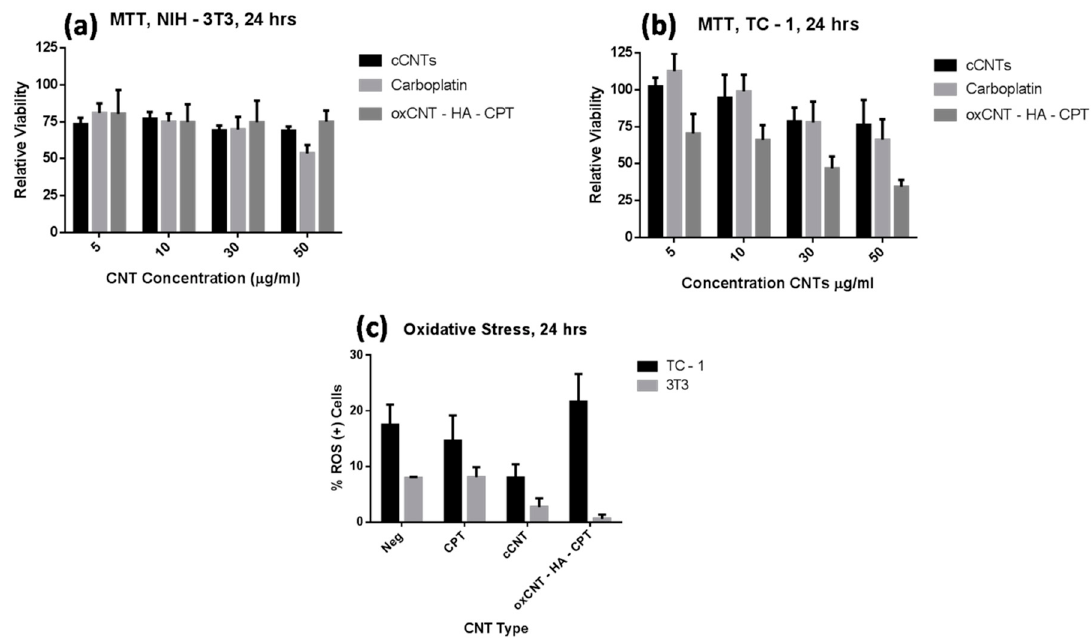
Figure 3. Cytotoxicity and oxidative stress induced by nanovectors. ( a ) 24 h MTT cytotoxicity assay of NIH/3T3 cells. ( b ) 24 h MTT cytotoxicity assay of TC-1 cells. ( c ) 24 h DHE ROS determination assay. ( Bars indicate the mean ± SD, n = 7, * p <